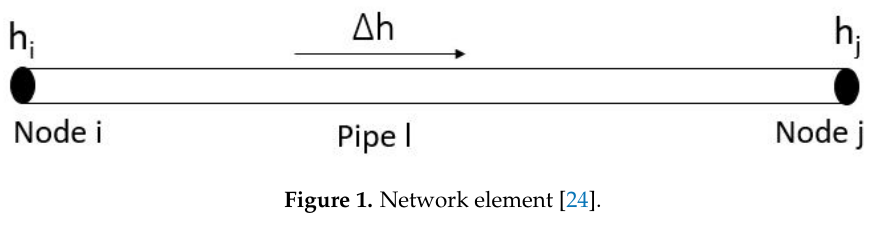
Figure 1. Network element